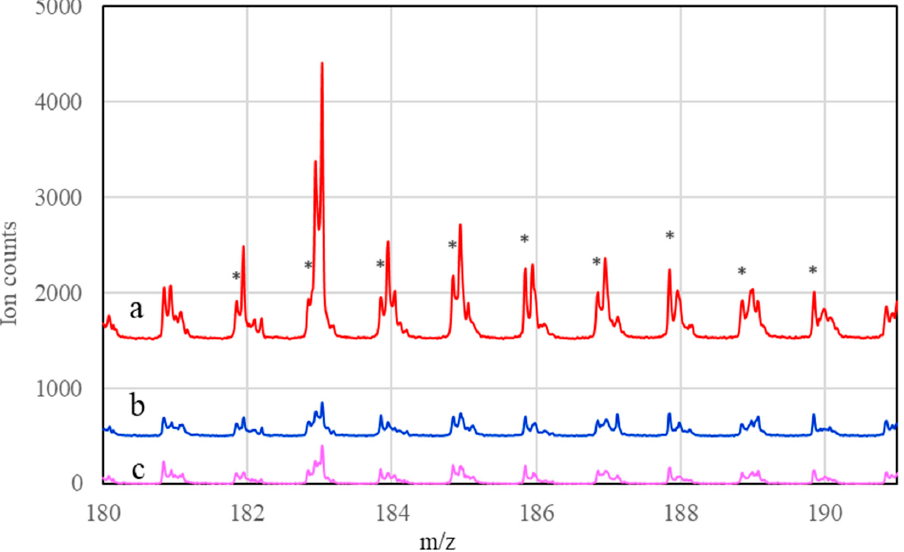
Table 4. Secondary ion counts for 5%Pd/TiO 2 and 2.5%Zn-5%Pd/TiO 2 catalysts.